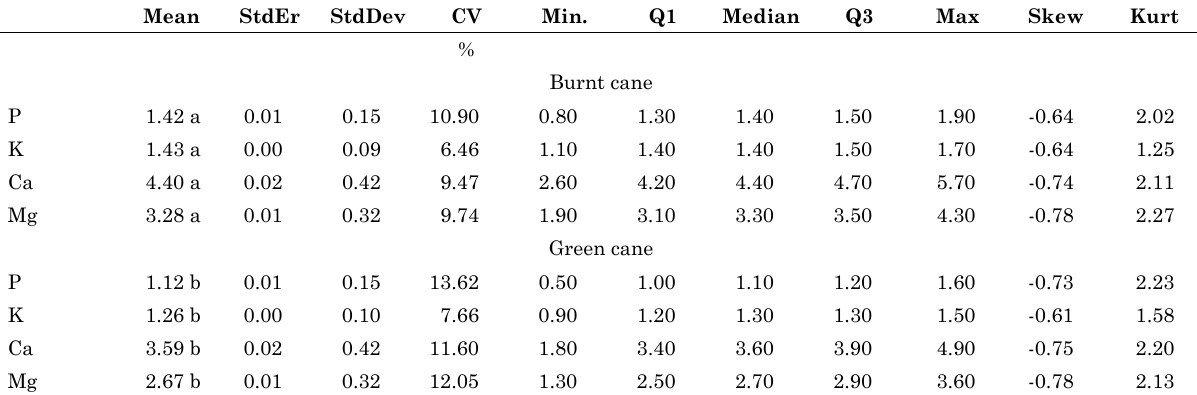
table 1. Descriptive statistics of p, K, ca and Mg soil depletion rates in burnt and green sugarcane harvest scenarios